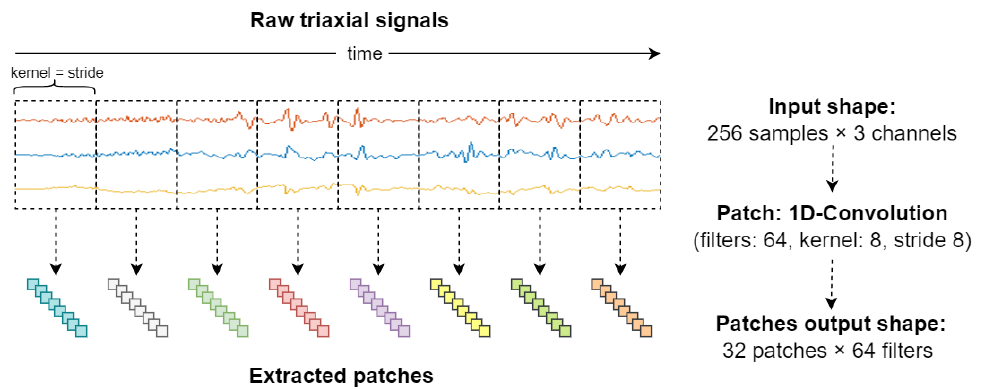
Figure 5. Patch input strategy with 1D-Convolution.